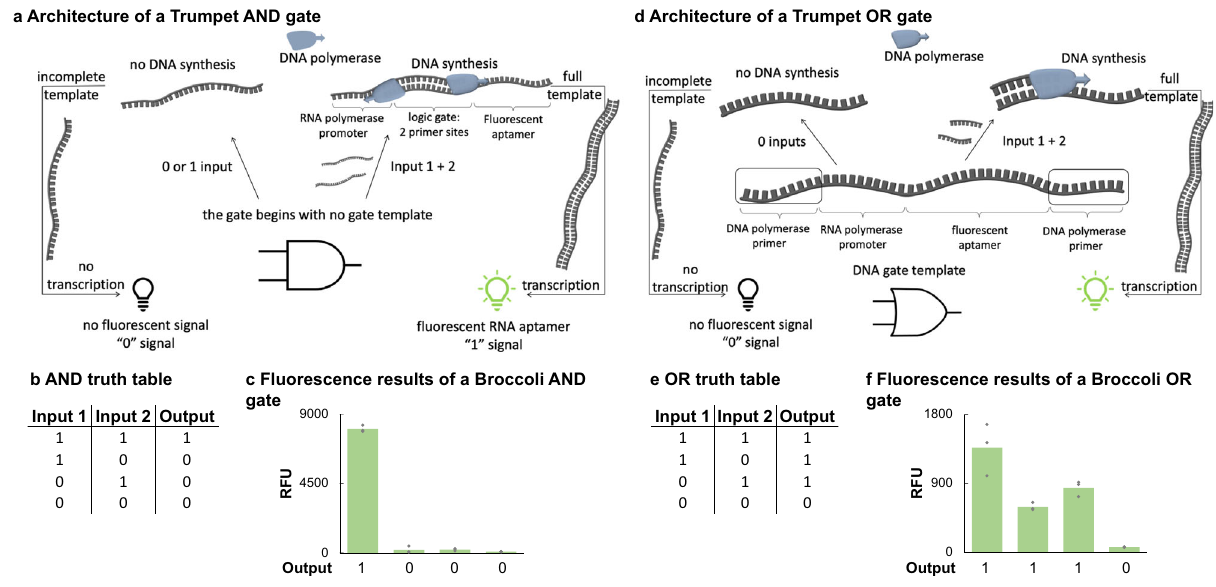
Fig. 4 | Trumpet AND and OR gates. a The general architecture of an AND gate. Thegatebeginswithoutagatetemplate.Instead,theinputsaremeanttohybridize directly with each other. A complete 106-base AND gate contains a T7 Max pro- moter sequence, a 30-base random sequence, and ends with the antisense sequence of an RNA aptamer. When zero or one input is present, the DNA poly- merase is unableto extend the inputto createadouble-strandedgate.The T7RNA polymerasereliesonadouble-strandedpromotersequence.ThispreventstheRNA polymerase from transcribing the aptamer, resulting in a 0 signal. When both inputs are present, DNA polymerase is able to extend each end to create a full double-stranded gate template. T7 RNA polymerase is then able to transcribe the RNAaptamer,and the aptamer fl uorescent signalis recorded as a 1. b AnAND gate truth table. c Fluorescent results of an AND gate encoding a Broccoli aptamer. d The general architecture of anOR gate. The gate template includes both 75-base